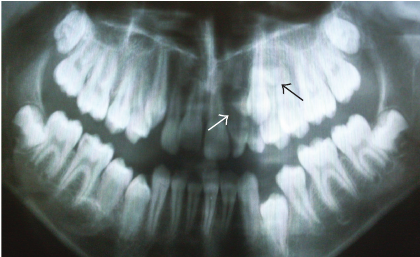
Figure 6: Two-year follow-up radiograph showing 2 additional supernumerary teeth, 1 in the maxillary left premolar region and 1 in the maxillary anterior region.